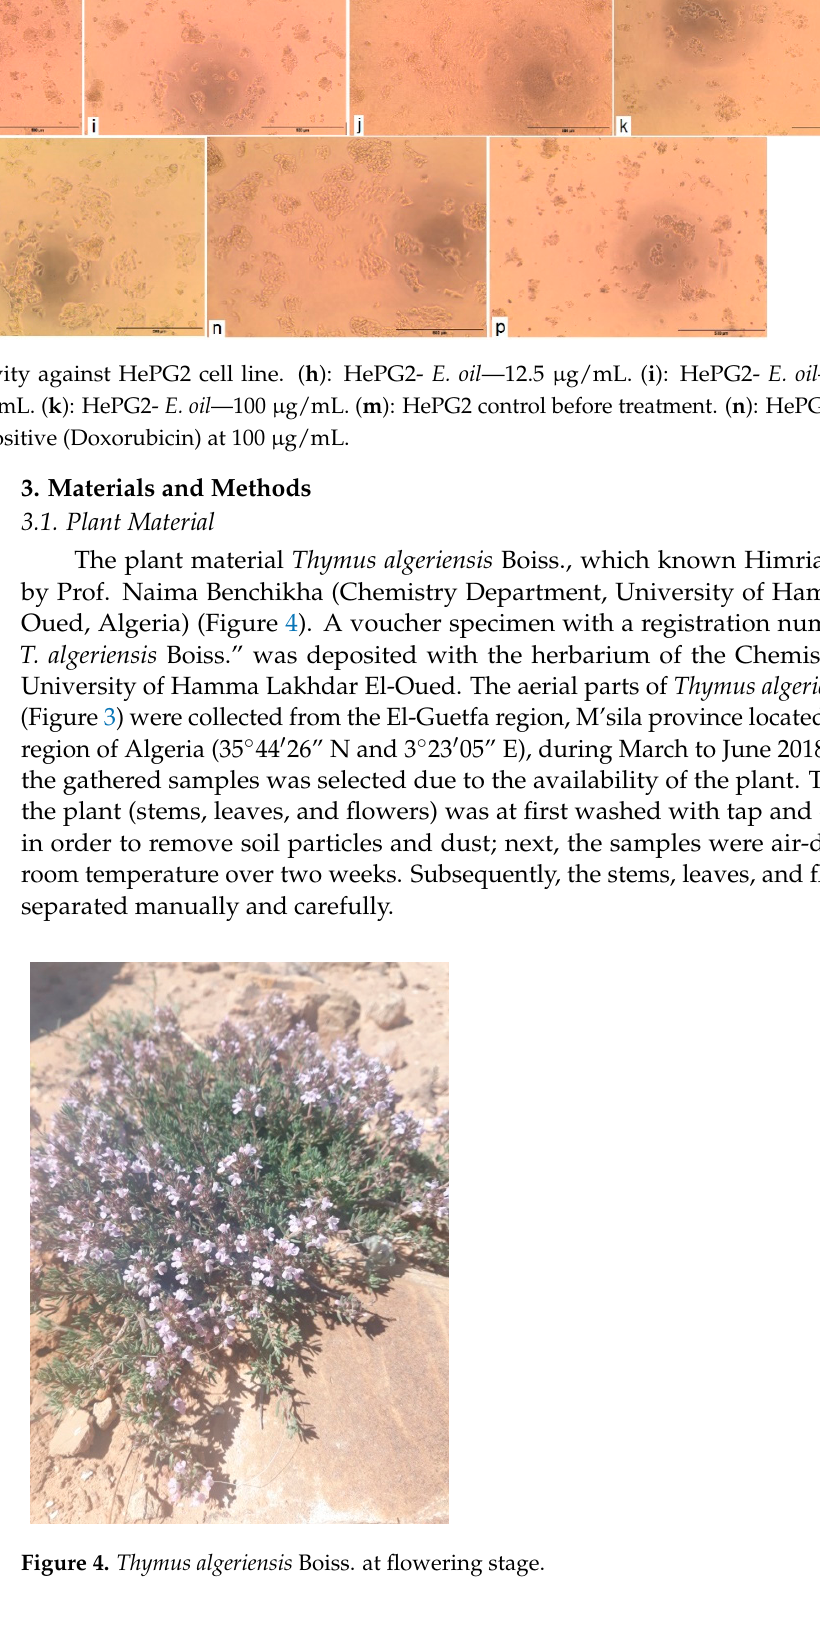
Figure 4. Thymus algeriensis Boiss. at flowering stage.